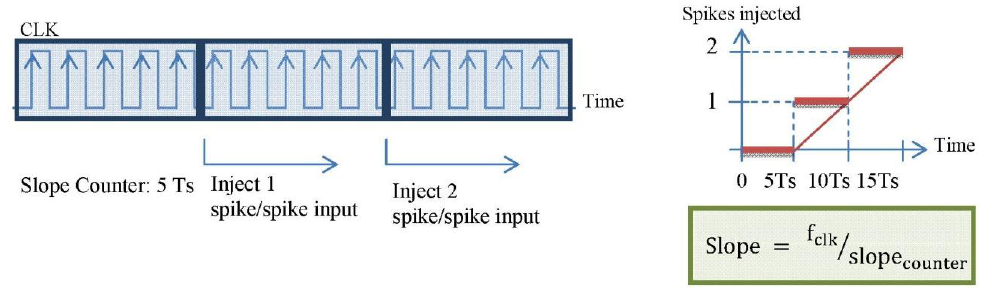
Figure 7. Explanation diagram of the implemented block. In this example, the slope counter is fixed to five clock periods; every time the count is reached one more spike will be injected. This way, and considering the firing rate, the discrete solid line is performed, and we were looking for the thinner line